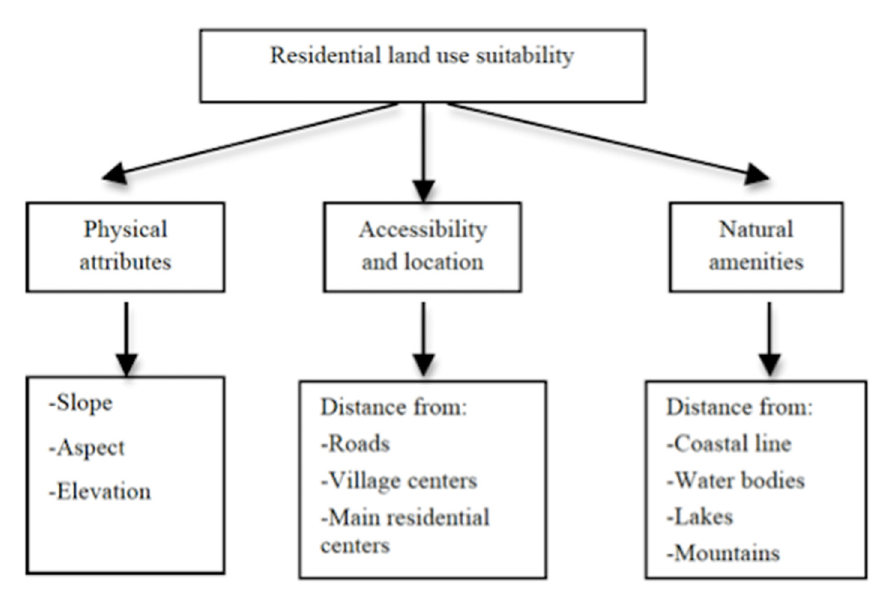
Figure 5. Decision hierarchy model for the AHP.